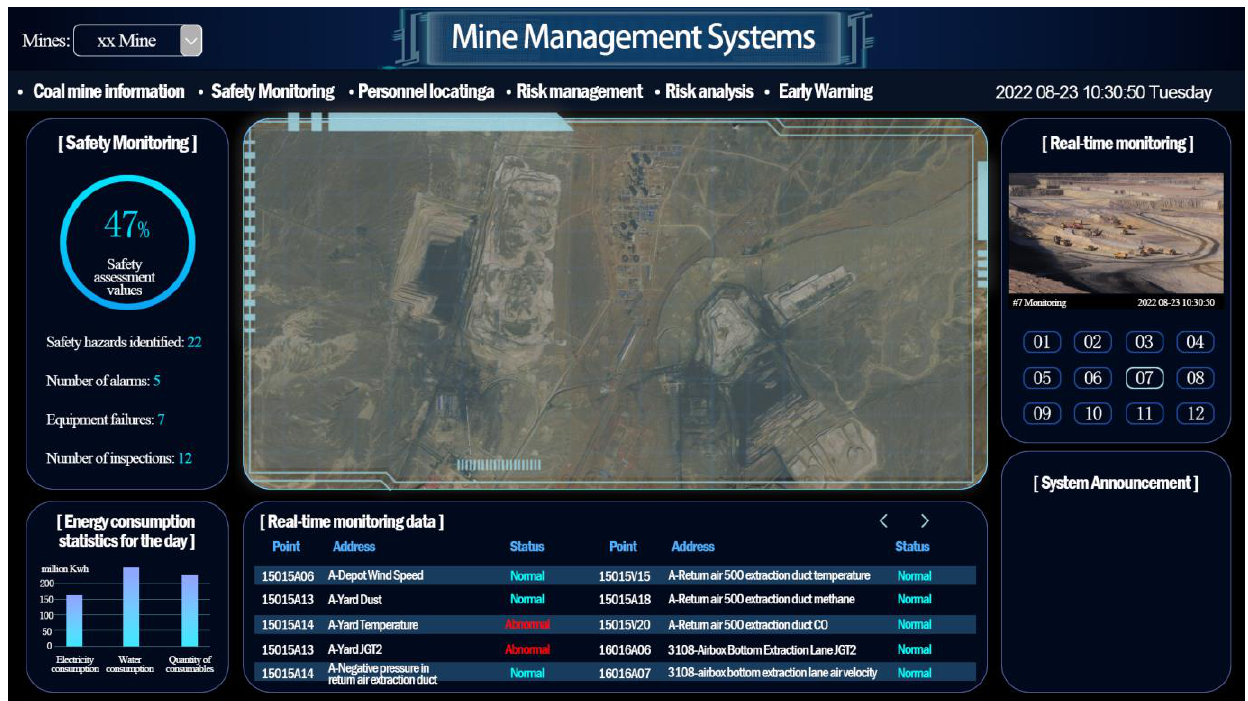
Figure 2. Mine management system ’ s